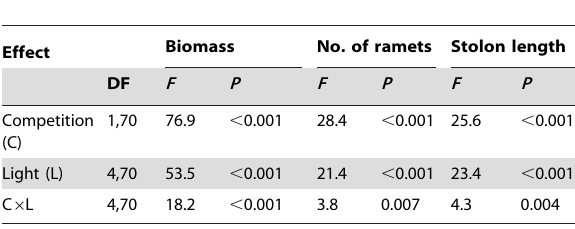
Table 1. ANOVAs for effects of competition and light treatments (intensity and heterogeneity) on the growth measures of Duchesnea indica at whole plant